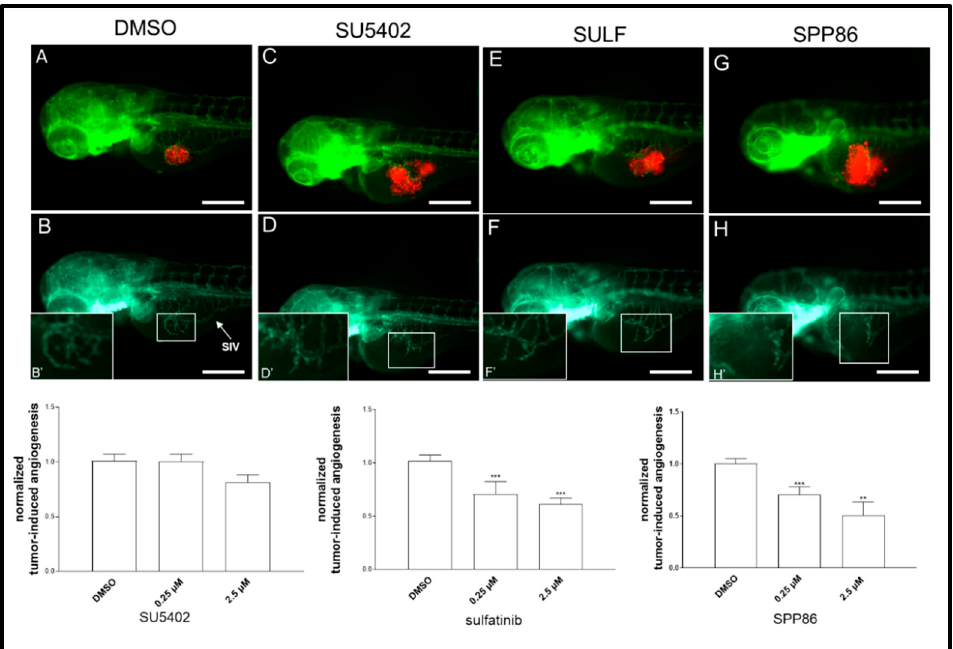
Figure 7. Effects of SU5402, sulfatinib and SPP86 on TT cell-induced angiogenesis in zebrafish. There is a representative image of an injected and treated embryo for each inhibitor (2.5 µM) and control (vehicle DMSO) in panels A, C, E, G. The red fluorescence channel, corresponding to red stained TT cells, was omitted in panels B, D, F and H to highlight the tumor-induced microvascular network sprouting from the SIV (sub-intestinal vein) plexus (white arrow). Digital magnifications of the graft region are shown in white-boxed regions B’, D’, F’ and H’. Graphs below report the results of tumor-induced angiogenesis quantification at 24 h post-injection. All images are oriented so that rostral is to the left and dorsal is at the top. Scale bar: 100 µm. **: p < 0.01, ***: p < 0.001.